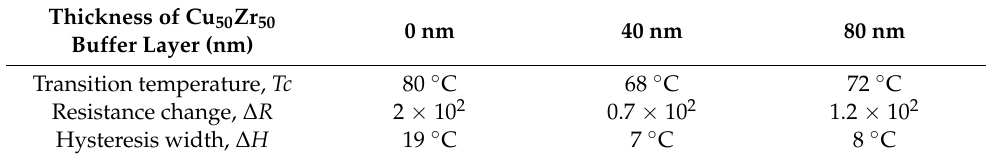
Figure 4. Temperature-dependent sheet resistance of the VO 2 /Cu 50 Zr 50 /glass thin films with different buffer layer thicknesses. ( a ) No film; ( b ) 40 nm thickness; ( c ) 80 nm thickness; and, ( d ) 160 nm thickness. The insets d(lgR)/dT ~ T are also shown to determine metal–insulator transition (MIT) temperatures. Table 1. Thermochromic transition characteristics of the multilayer VO 2 /Cu 50 Zr 50 /glass thin